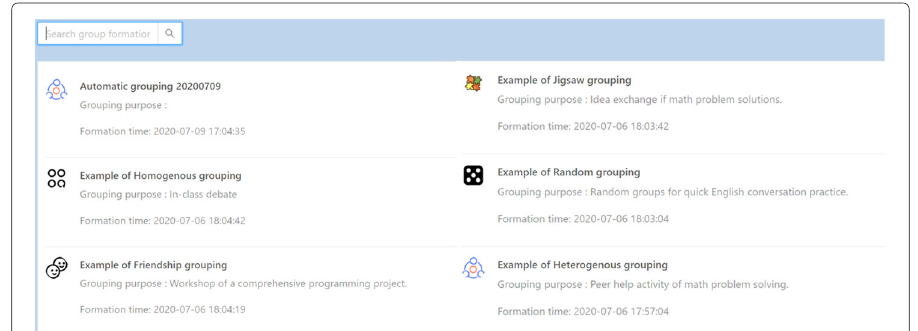
Fig. 8 Prior grouping interface: Examples of different possibilities (algorithms and purposes) for using group work module